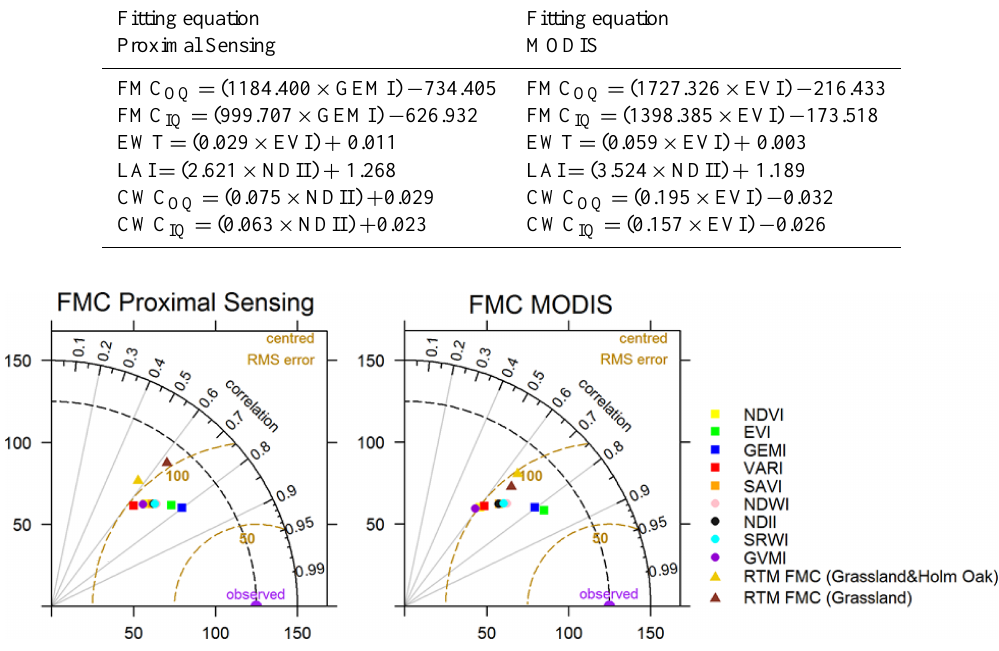
Figure 7. Comparison of empirical vs RTM models to estimate FMC with proximal sensing (left) and MODIS (right). RTM FMC (Grassland) obtained from the LUT proposed by (Yebra et al., 2008b). RTM FMC (Grassland & Holm Oak) obtained from the LUT proposed by Jurdao et al.